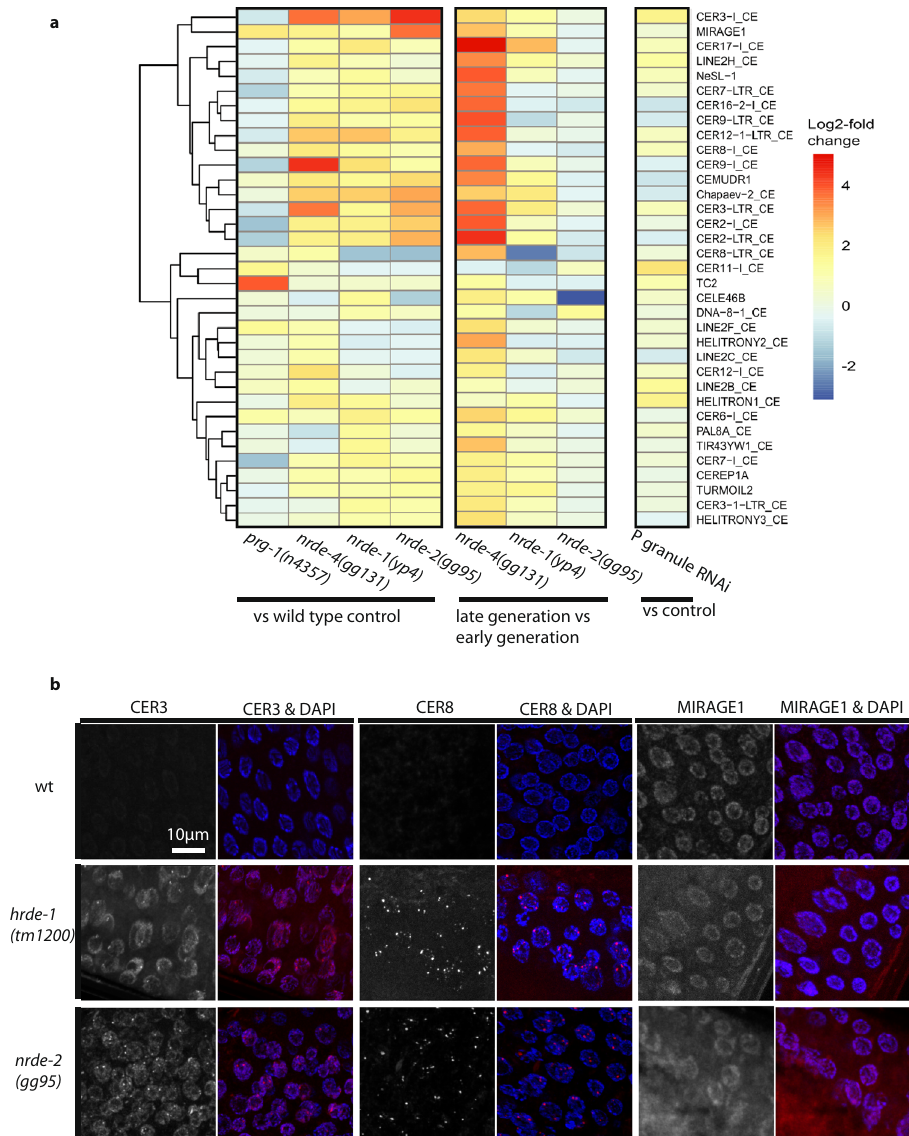
Fig. 5 Transcriptome pro fi ling of germ granule de fi cient larvae of Piwi pathway genome silencing mutants nrde-1 and nrde-4 . a Log2-fold changes in transposon transcript abundance in mutant vs wild type, late vs early generation, or P granule RNAi-treated vs control. Transposons upregulated at least twofold in nrde-1 , nrde-4 , or prg-1(n4357) are shown. b Single molecule RNA FISH signals for CER3, CER8, and MIRAGE1 elements in the adult germline. More than seven animals were examined in each group from two experimental datasets showing similar results and representative images are displayed (CER3: wild type n = 8; hrde-1 n = 7; nrde-2 n = 20 CER8: wild type n = 15; hrde-1 n = 13; nrde-2 n = 13; MIRAGE1: wild type n = 10; hrde-1 n = 13; nrde-2 n =